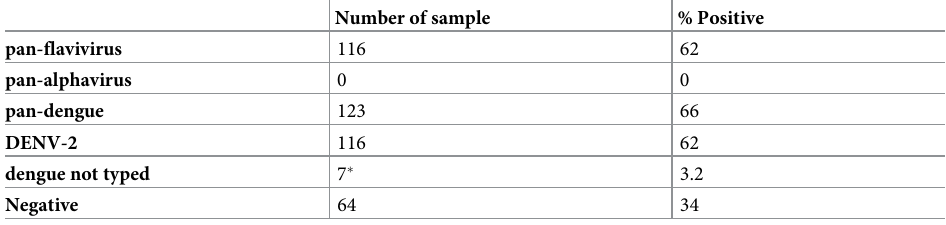
Table 5. Results of clinical sample obtained during the Vanuatu